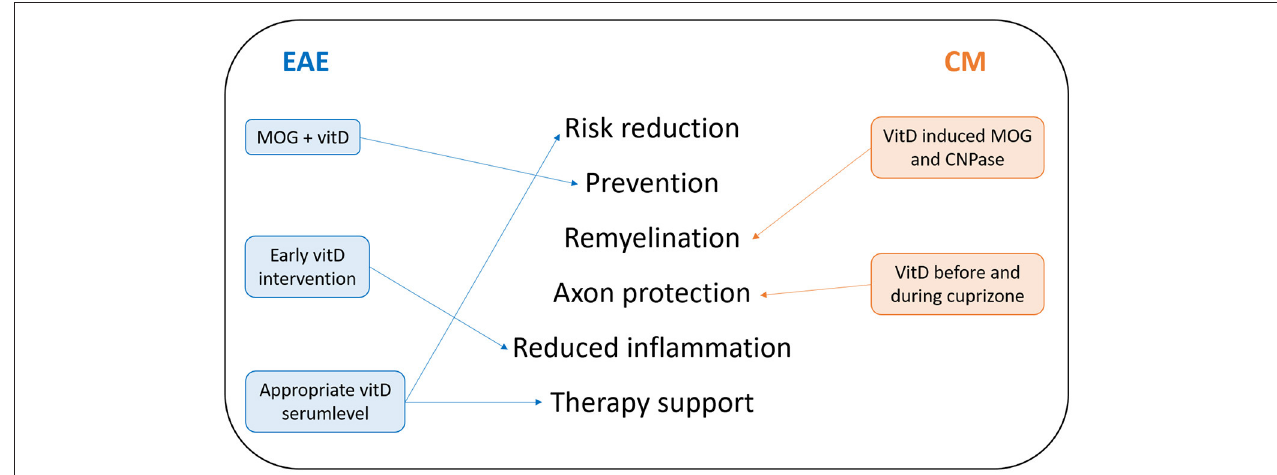
FIGURE 2 | Summary of recent findings of protective vitD effects. Most results upon vitD effects in MS-related animal models were obtained by EAE and the cuprizone model (CM). Lessons from EAE are written on the left side in blue; lessons from CM are shown in orange on the right side. In the middle of this summary, recent research findings of protective effects of vitD are